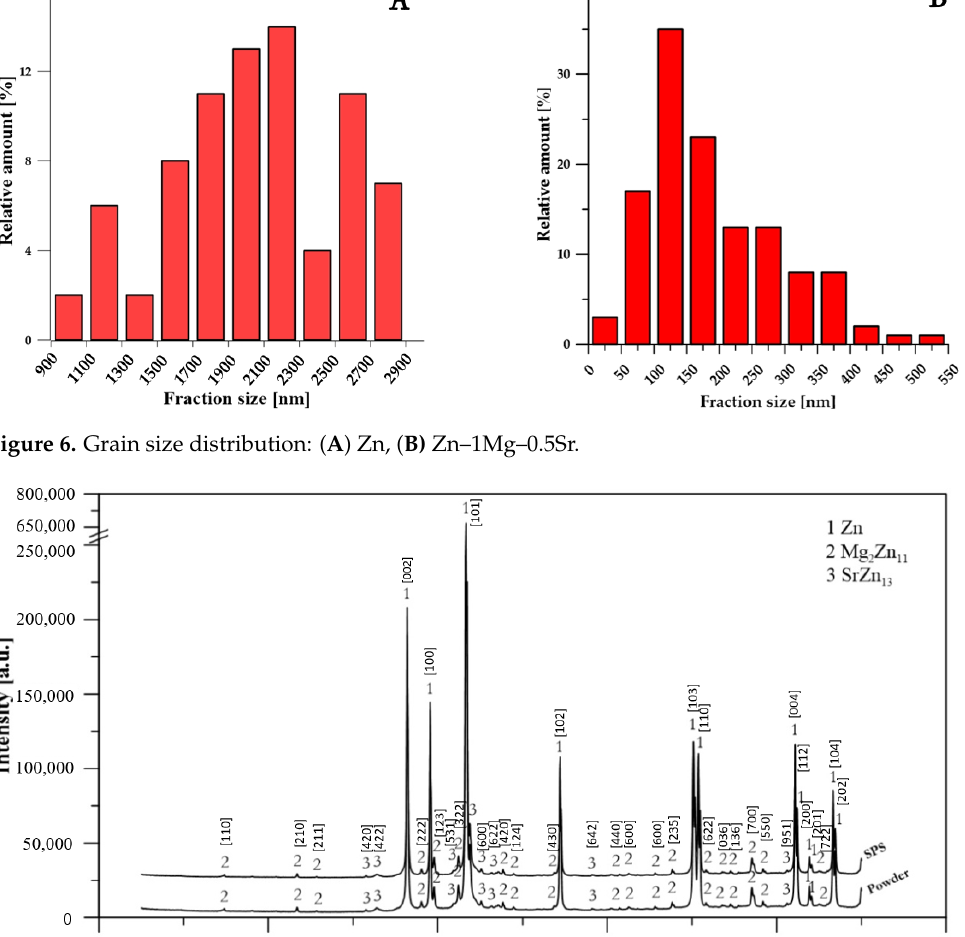
Figure 7. XRD diffractogram of mechanically alloyed Zn – 1Mg – 0.5Sr powder and compact.